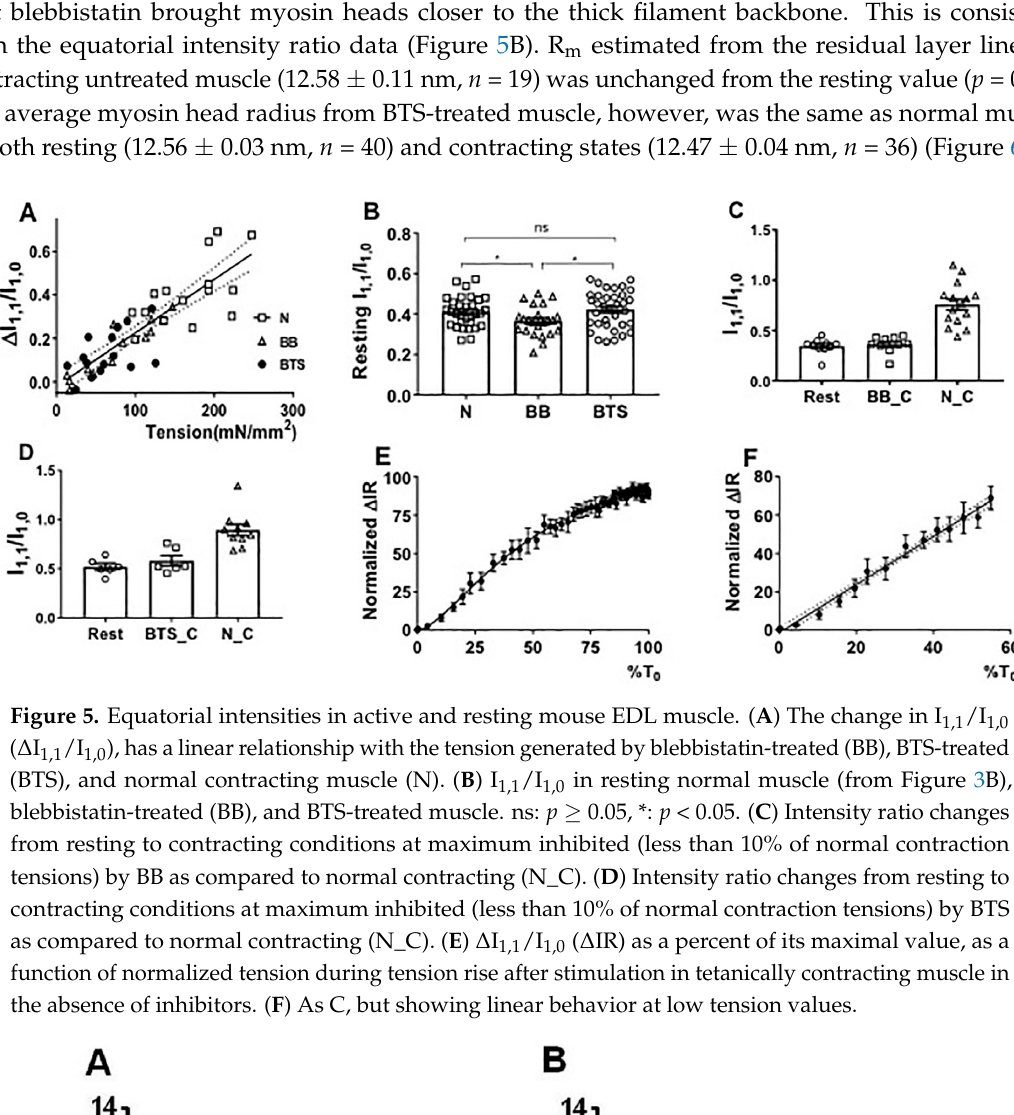
Table 1. Peak width parameters for the equatorial reflections in resting and normal contracting muscle.